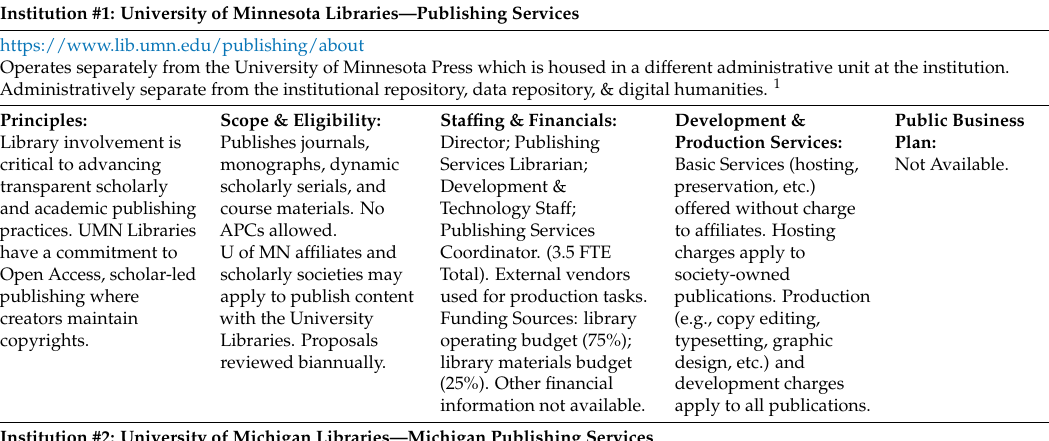
Table 2. Case Studies of Library Publishing